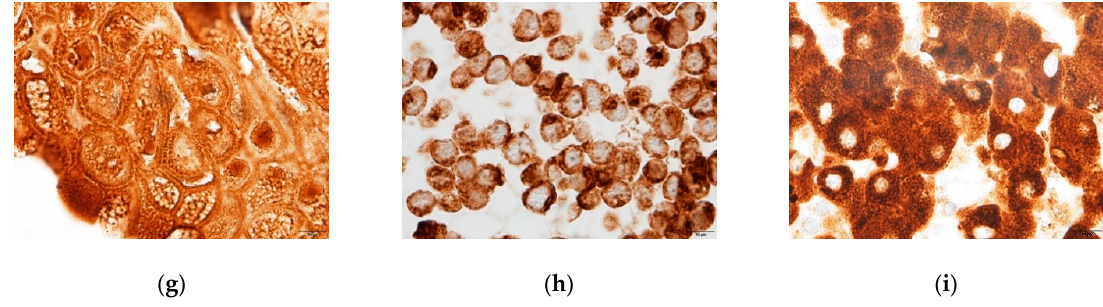
Figure 4. Immunostaining of HNF4 α ( a – c ), CYP3A4 ( d – f ), and CYP1A2 ( g – i ). ( a , d , g ) DM day 12 organoids; ( b , e , h ) HepG2 cells; ( c , f , i ) Human liver tissue. Green florescent signals indicated positive staining for HNF4 α (white arrows). Brown color signals indicated positive staining for CYP3A4 or CYP1A2. Original magnifications, × 400 ( a – c ) and × 1000 ( d – i ). Bar indicates 20 µ m ( a – c ), and 10 µ m ( d – i ).